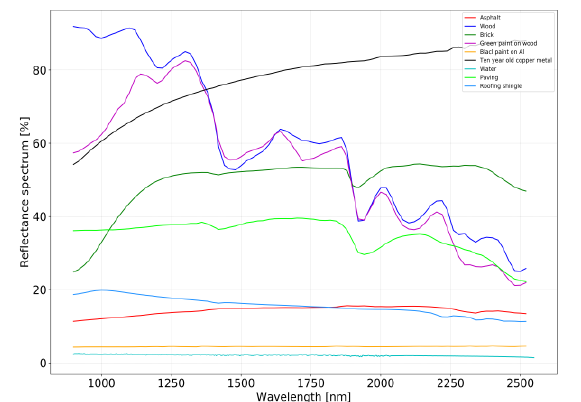
Figure 2 . Reflectance spectra for nine surface types chosen for their different spectral